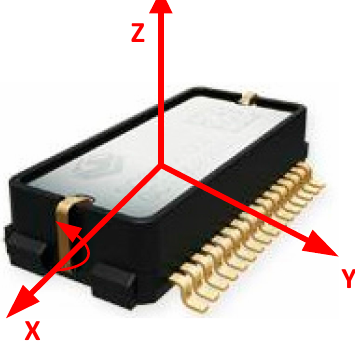
Figure 2. Definition of SCC1300-D04 body frame.